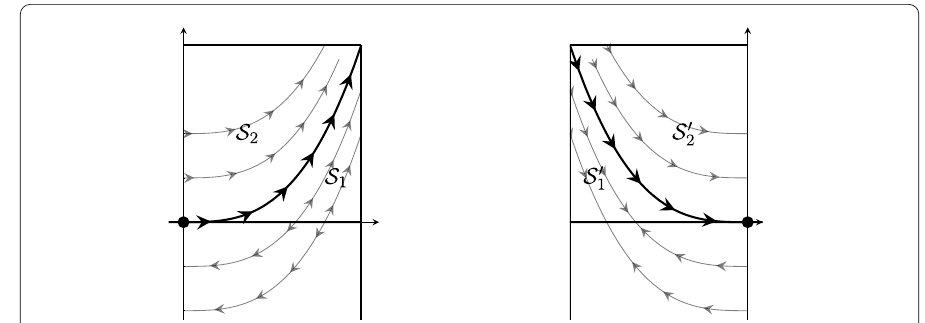
Figure 5 The regions S 1 , S 2 , S (cid:10) 1 , and S (cid:10) 2 guaranteed by Propositions 1 and 2